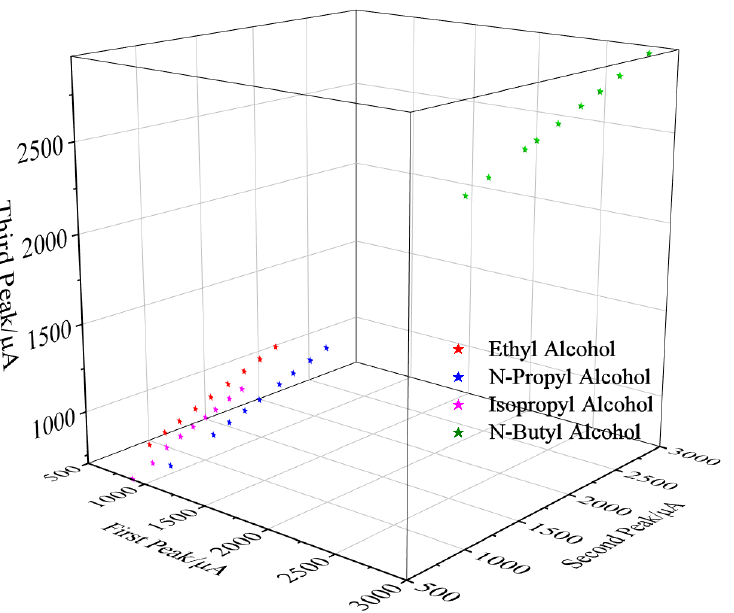
Figure 10. The diagram between characteristic peak output currents vs ppm of four alcohol homo- logue gases under TW-3.